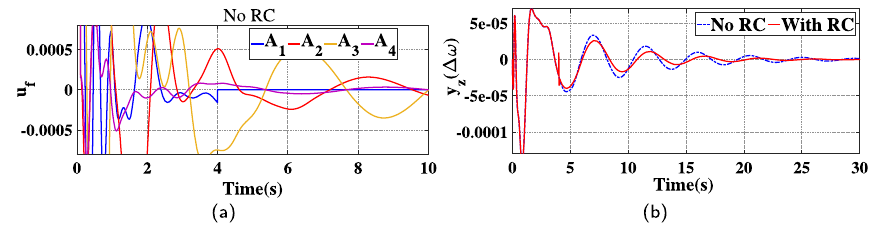
Fig. 8 Fault at actuator A 1 at t=4s: ( a ) Wide area control input to power system in absence of RC; ( b ) Comparison of system performance path (Change in rotor speed of